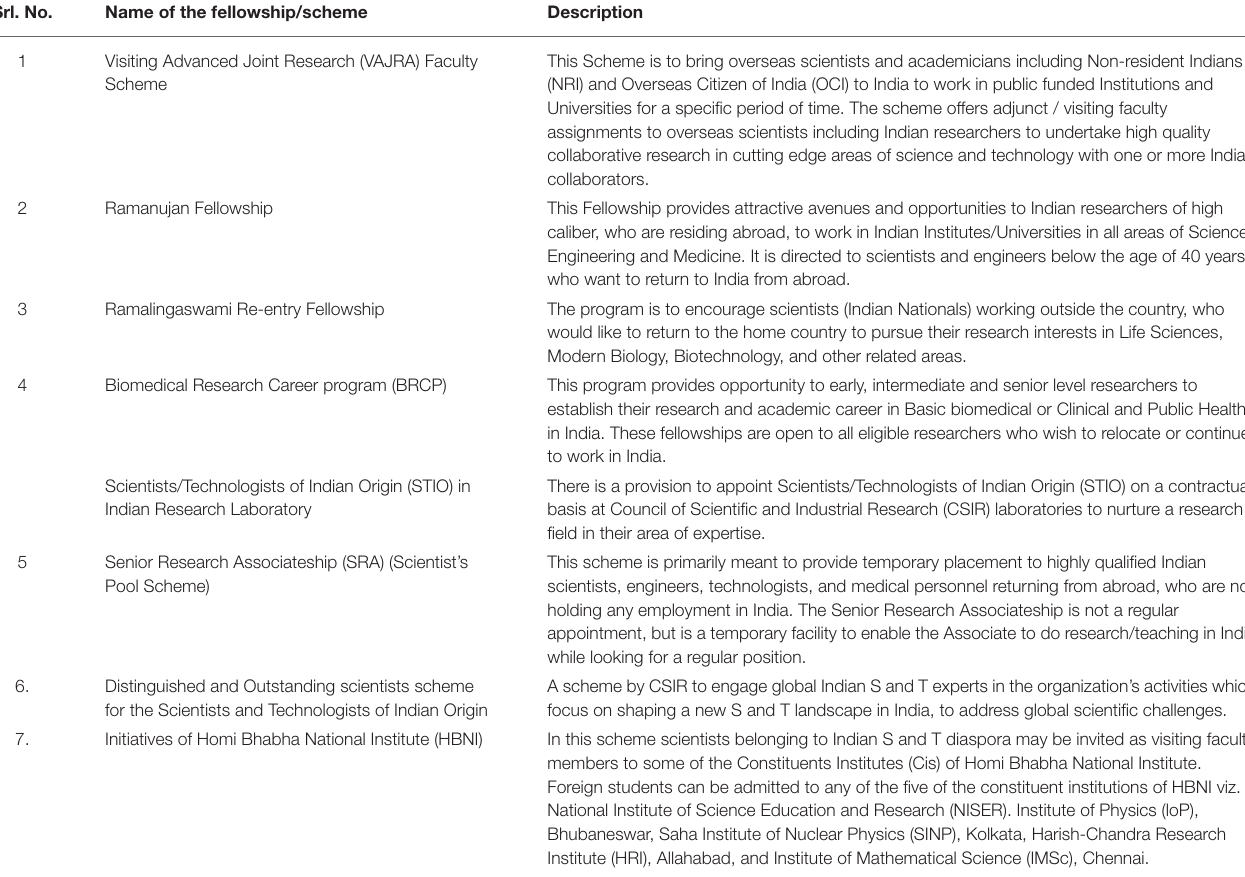
TABLE 2 | Fellowships and schemes for Indian researchers residing in foreign countries. Srl.